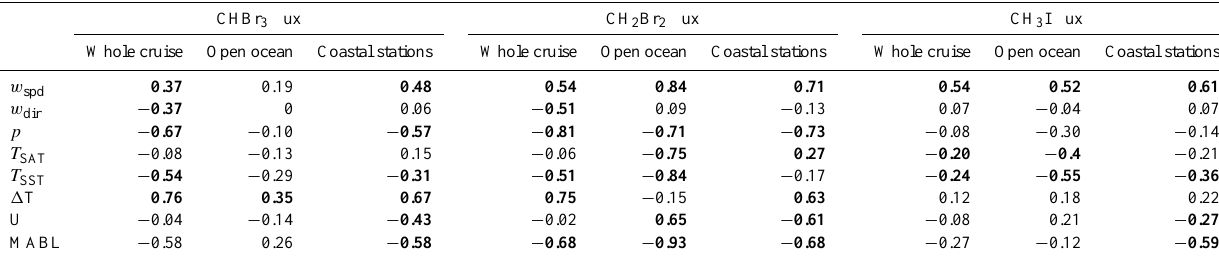
Table 4. Correlation coefficients of bromoform (CHBr 3 ), dibromomethane (CH 2 Br 2 ) and methyl iodide (CH 3 I) fluxes with wind speed ( w spd ), wind direction ( w dir ), surface air pressure ( p ), surface air temperature ( T SAT ), sea surface temperature ( T SST ), temperature differ- ence ( 1T = T SAT – T SST ), relative humidity ( U ), and MABL height. Whole cruise (leg 2 and 3) includes n = 109 samples for all parameters except MABL height (21 samples), open ocean (leg 2 except stations 3–6 and leg 3) includes n = 37 samples for all parameters except MABL height (8 samples) and coastal stations (stations 3–6) include n = 70 samples for all parameters except MABL height (13 samples). Bold coefficients have a p value of less than 5%.